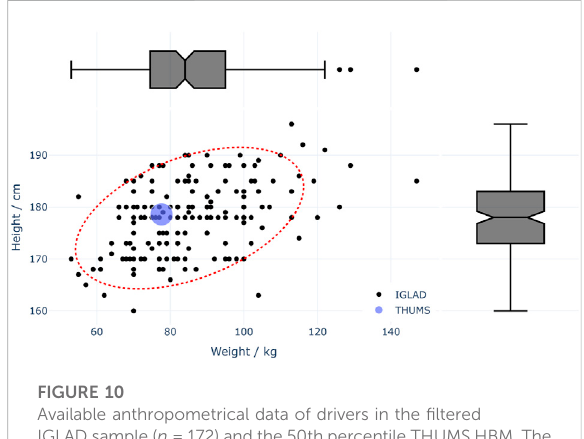
FIGURE 10 Available anthropometrical data of drivers in the fi ltered IGLAD sample ( n = 172) and the 50th percentile THUMS HBM. The red dotted line illustrates the 95% con fi dence ellipse for IGLAD